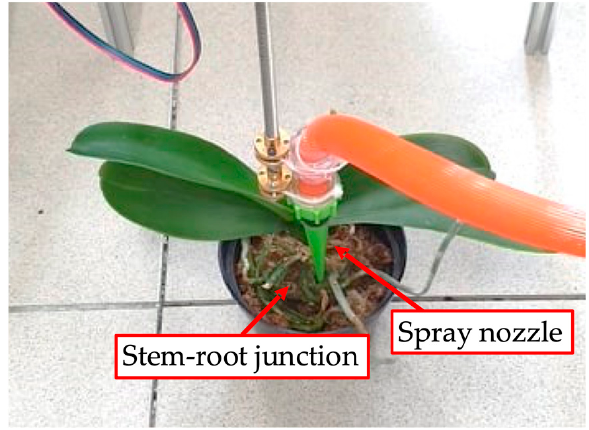
Figure 30. Demonstration of watering on stem-root junction.